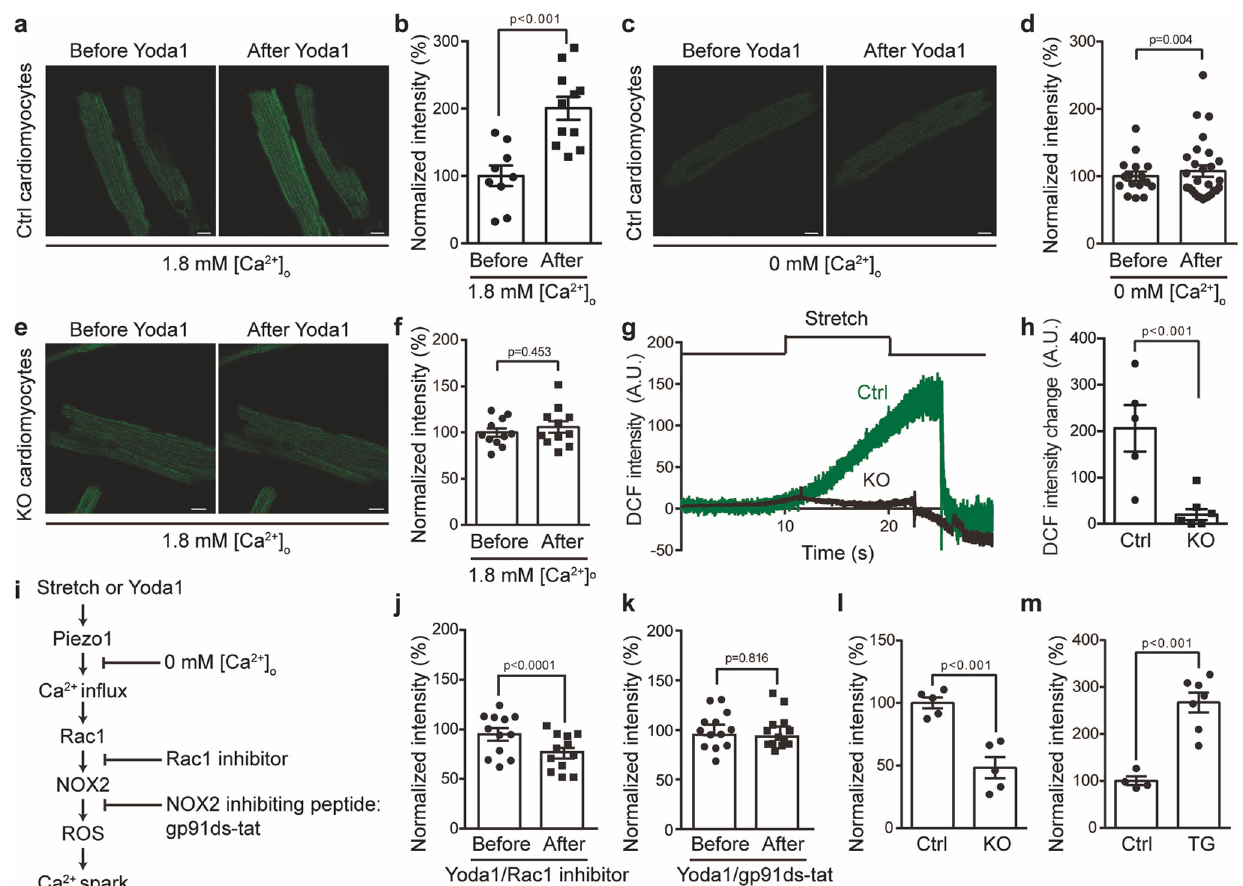
Fig. 5 Piezo1 mediates stretch-induced and homeostatic ROS signaling. a , c Representative DCF fl uorescent images of Ctrl cardiomyocytes before and after application of Yoda1 in the presence ( a ) or absence ( c ) of 1.8 mM [Ca 2 + ] o . Scale bar, 10 μ m. b , d Scatter plot of normalized DCF intensity of Ctrl cardiomyocytes before and after application of Yoda1 in the presence (11 cells) or absence (15 cells) of 1.8 mM [Ca 2 + ] o . 3 mice for each group. Paired student ’ s t-test, two-sided. e Representative DCF fl uorescent images of KO cardiomyocytes before and after application of Yoda1 in the presence of 1.8 mM [Ca 2 + ] o . Scale bar, 10 μ m. f Scatter plot of normalized DCF intensity of KO cardiomyocytes (11 cells from 3 KO mice) before and after application of Yoda1 in the presence of 1.8 mM [Ca 2 + ] o . Paired student ’ s t-test, two-sided. g Representative DCF fl uorescent imaging trace of Ctrl or KO cardiomyocytes in response to 8% axial stretch. h Scatter plot of stretch-induced DCF fl uorescence intensity change of Ctrl (5 cells) or KO cardiomyocytes (6 cells). 3 mice for each group. Unpaired student ’ s t-test, two-sided. i The proposed scheme of Piezo1-mediated ROS-generating pathway. j Scatter plot of normalized DCF intensity of wild-type cardiomyocytes (12 cells from 3 mice of three independent experiments) in response to Yoda1 together with the Rac1 inhibitor. Paired student ’ s t-test, two-sided. k Scatter plot of normalized DCF intensity of wild-type cardiomyocytes (14 cells from 3 mice of three independent experiment) in response to Yoda1 after pre-incubation with the membrane-permeable NOX2 inhibiting peptide gp91ds-tat. Paired student ’ s t-test, two-sided. l Scatter plot of normalized DCF intensity of Ctrl (5 cells) and KO (5 cells) cardiomyocytes for three independent experiments. Unpaired student ’ s t-test, two-sided. m Scatter plot of normalized DCF intensity of Ctrl (4 cells) and TG (7 cells) cardiomyocytes from three independent experiments. Unpaired student ’ s t-test, two-sided. Values are mean ± SEM in b , d , f , h , j – m doxorubicin-induced dilated cardiomyopathy 48 . Western blotting of consistent with abnormal Ca 2 + handling and ROS signaling in the Piezo1-TG cardiomyocytes. the anti-Flag-immunoprecipitated samples from cardiomyocytes derived from doxorubicin-treated Piezo1-Flag-KI mice revealed more abundant Piezo1 proteins than that from the saline-treated Piezo1-Flag-KI mice (Fig. 8a). The sample from saline-treated wild- type control mice was used as a negative control for demonstrating the Piezo1-speci fi c western blotting signal (Fig. 8a). Consistent with upregulation of Piezo1 proteins in diseased mouse and rat hearts (Fig. 8a) 34 , RT-PCR revealed a 5-fold increase in the mRNA expression of Piezo1 in human heart samples with hypertrophic cardiomyopathy compared to normal heart samples (Fig. 8b and Supplementary Excel Sheet). Thus, Piezo1 is upregulated under